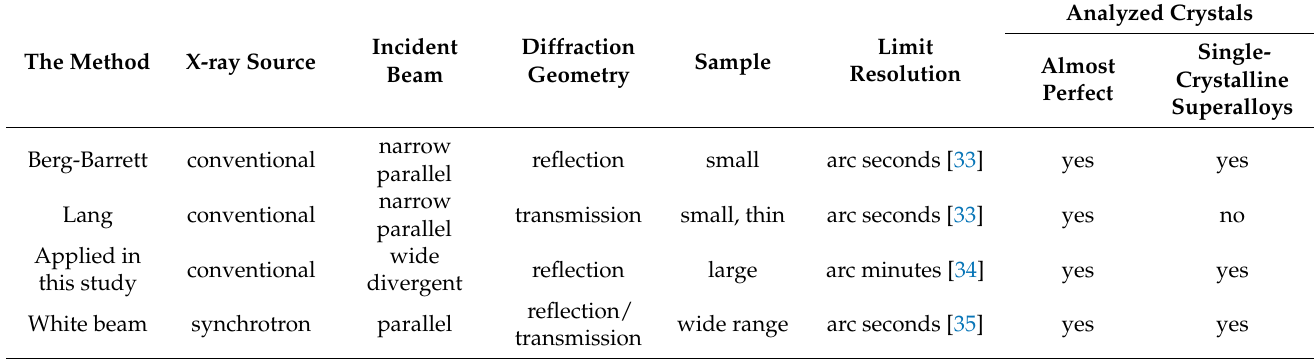
Table 1. The parameters of different X-ray topography methods and their